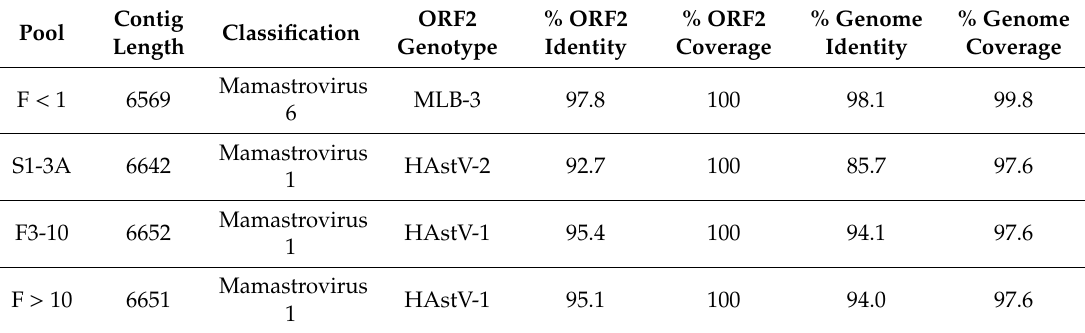
Table 3. Characterization of human astrovirus contigs detected in the tested fecal